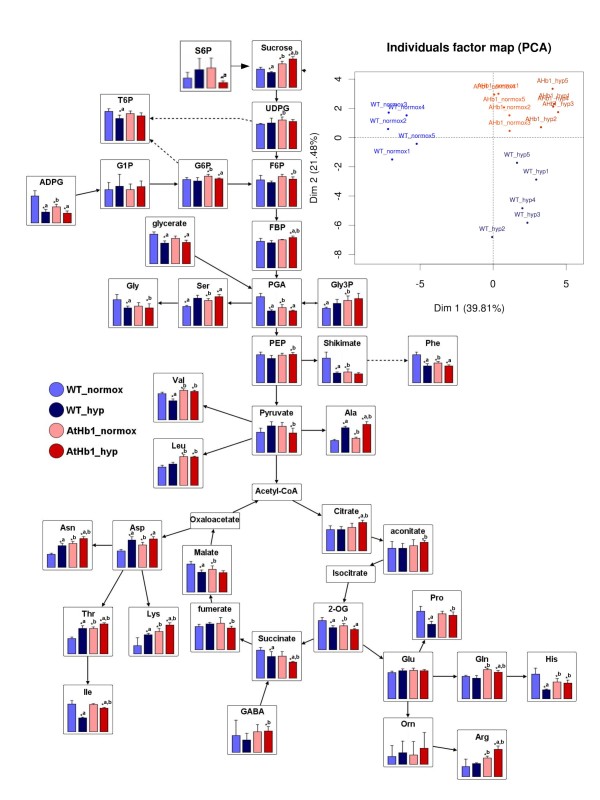
Metabolite patterns in seeds of AtHb1-overexpressing and WT plants under control conditions (21 kPa O2) and moderate hypoxia (10.5 kPa O2) visualized by VANTED software [75]. "*a" indicates statistically significant differences after hypoxic treatment in each genotype, "*b" indicates statistically significant differences between the genotypes under control and hypoxic conditions (t-test, p < 0.05). Mean values ± standard deviation are presented (data in Additional file 9). The insert shows results of a principal component analysis of the metabolite data set. 20 samples in two dimensional space are given, where the names are coloured according to the 4 different sample types (WT and AtHb1, under either control or hypoxic conditions; with 5 biological replicates each).